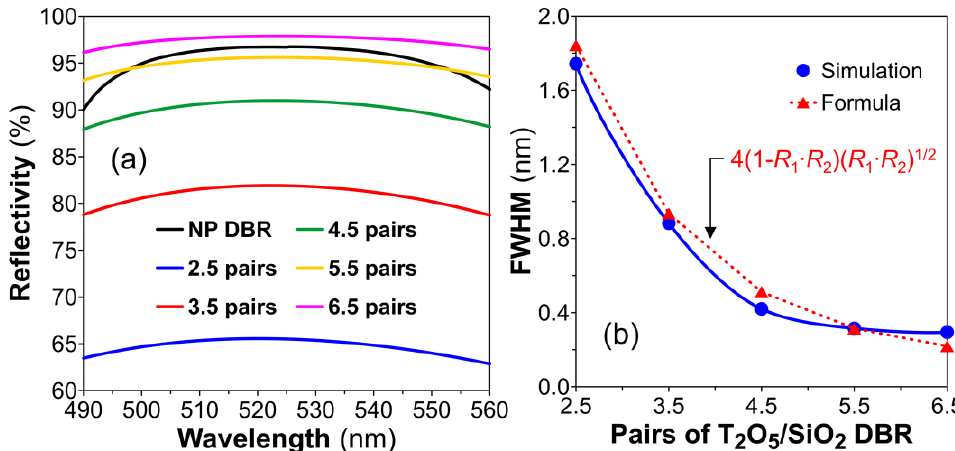
Figure 8. ( a ) Reflectivity spectra of the top reflective mirror with different pairs of Ta 2 O 5 /SiO 2 DBRs. The optical reflectivity of 11.5 pairs of GaN/NP-n-GaN DBR was plotted by the black line. ( b ) FWHMs with different numbers of Ta 2 O 5 /SiO 2 DBR pairs.